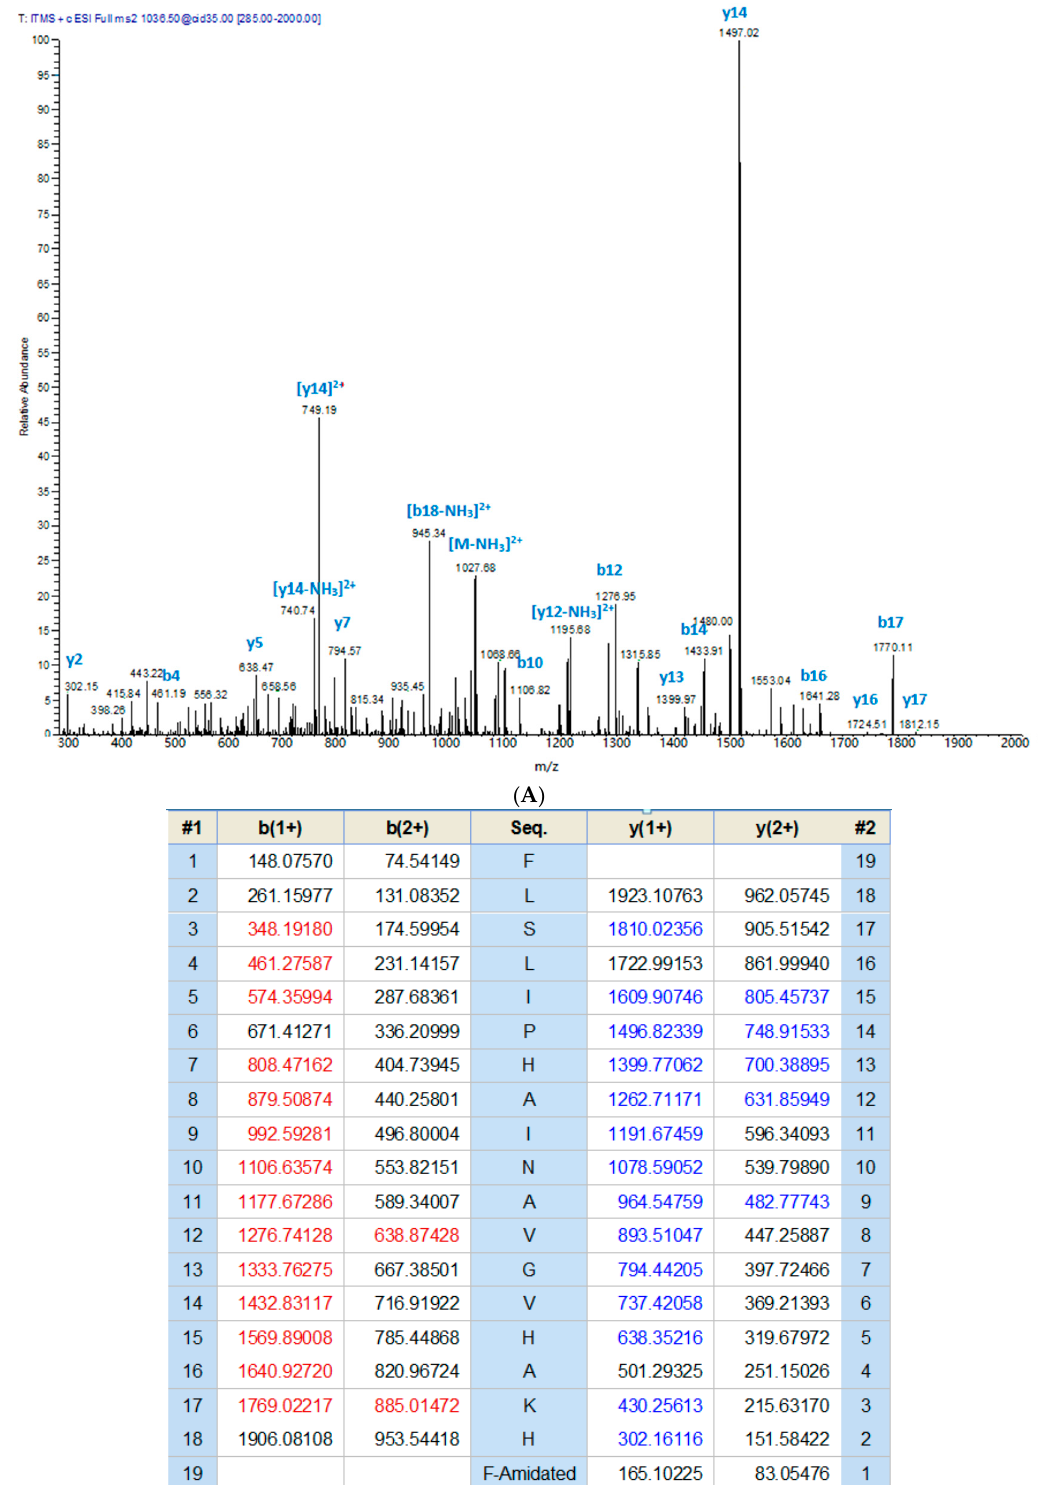
Figure 2. The RP-HPLC chromatogram of the skin secretion of Phyllomedusa tarsius . The components were monitored at a wavelength of 214 nm. The retention time of phylloseptin-PT is marked by an arrow.